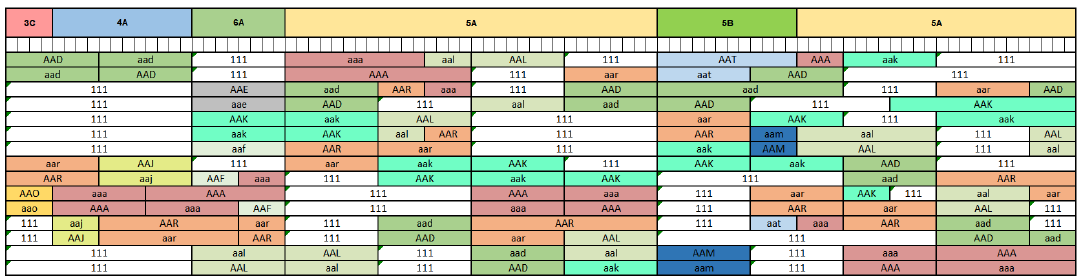
Figure 2. Example of solution